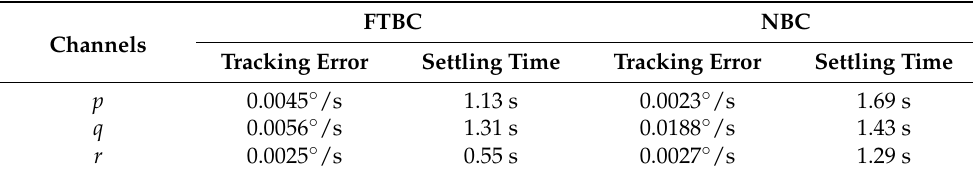
Table 5. Comparison of the angular rate tracking performance of FTBC and NBC. FTBC NBC Channels Tracking Error Settling Time Tracking Error Settling Time